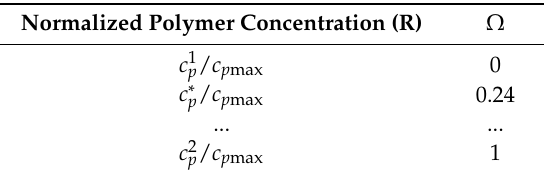
Table 1. The interpolation